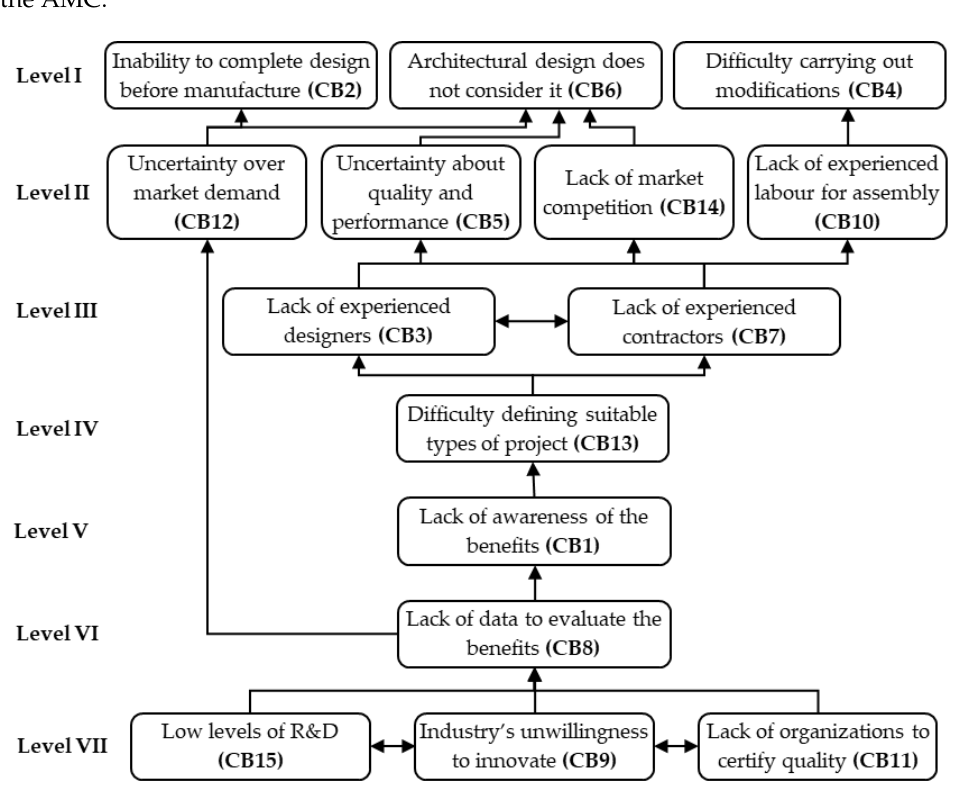
Figure 2. The ISM model of the barriers to the AMC in Portugal. Lower-level barriers are placed at the top of the model, Level I, which includes the inability to complete the design before manufacture (CB2), the architectural design does not consider modular construction (CB6) and difficulty carrying out on-site modifications (CB4). These barriers are not expected to excerpt influence over others but are heavily influenced by other barriers. Levels II to VI are considered intermediate levels in the model. Level II includes the uncertainty over quality and performance (CB5), lack of experienced labor for on-site as- sembly (CB10), uncertainty over market demand (CB12) and lack of market competition (CB14). Level III comprises lack of experienced designers (CB3) and lack of experienced contractors (CB7), and Level IV includes difficulty defining the most suitable projects